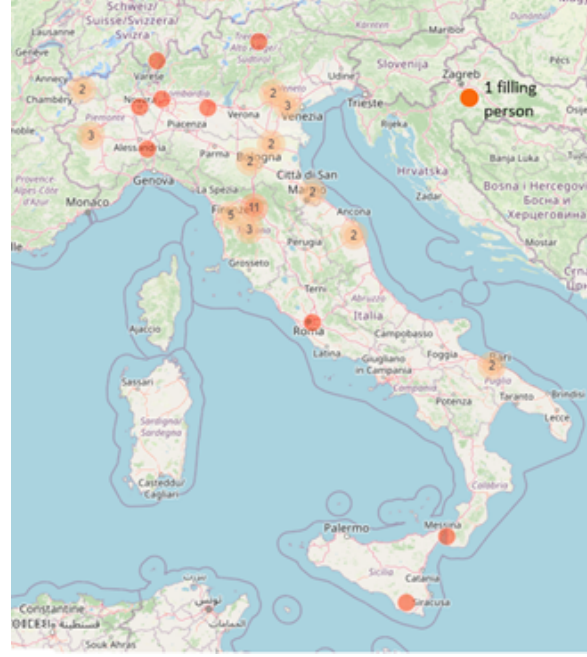
Figure 14: Distribution of people who filled in the